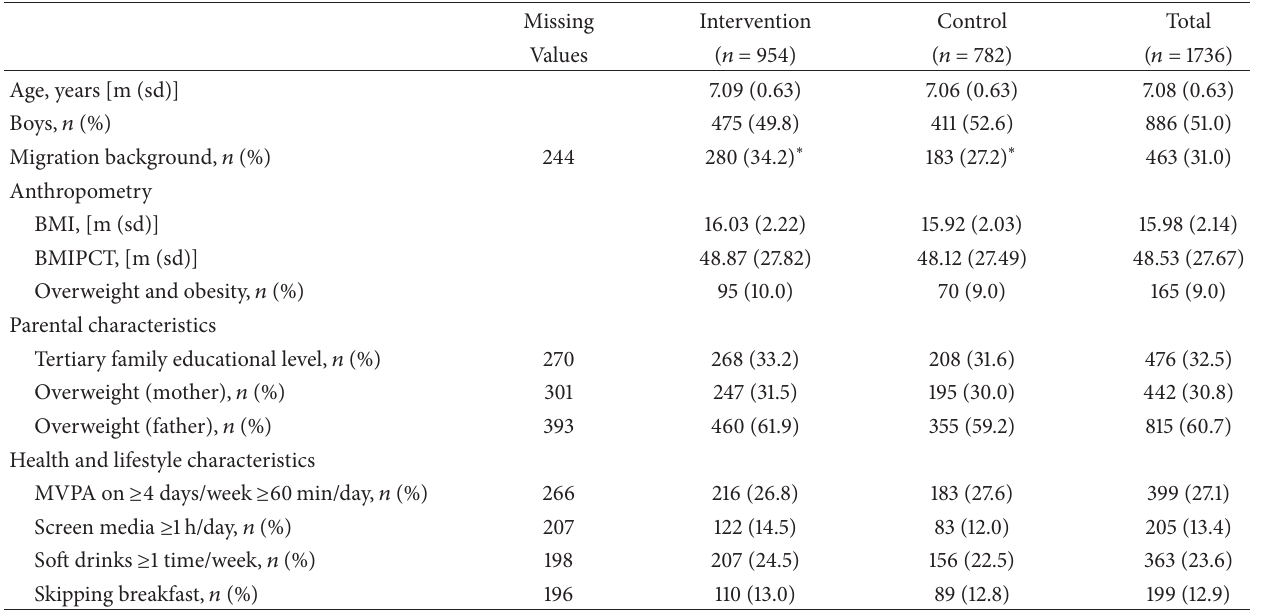
Table 1: Baseline characteristics of participants in the “Join the Healthy Boat” study. Missing Intervention